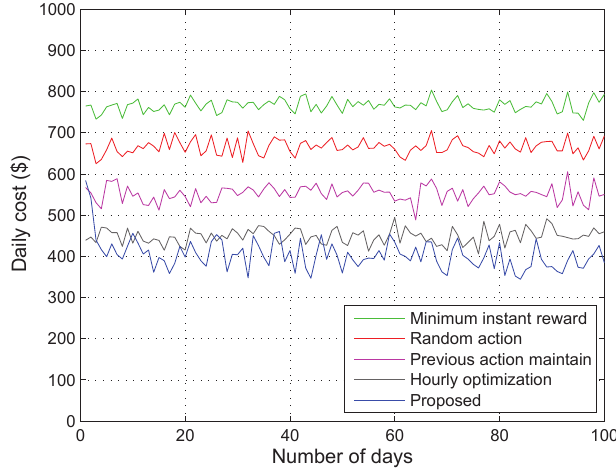
Figure 6. Daily cost comparison with respect to time in